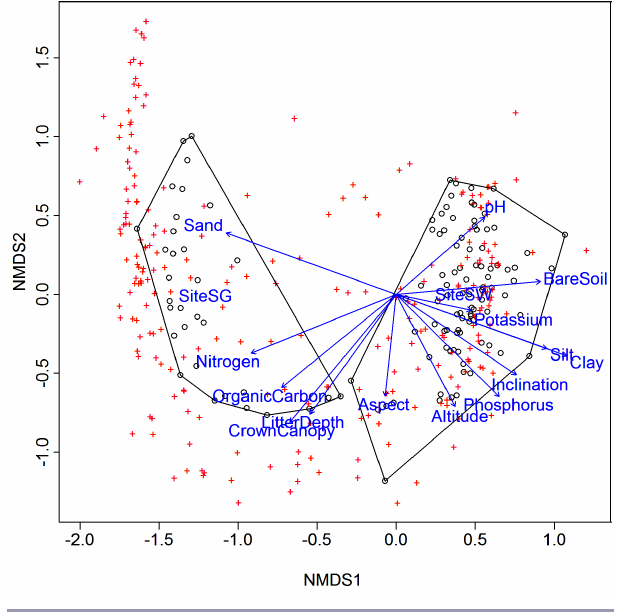
Fig. 4 . Tri-plot of species, relevés, and environmental variables resulting from fitting significant-environmental variables on nonmetric multidimensional scaling (NMDS) analysis of sacred groves (SG) and surrounding silvopastoral woodlands (SW). To prevent overcrowding in the diagram, species names and relevé numbers are not